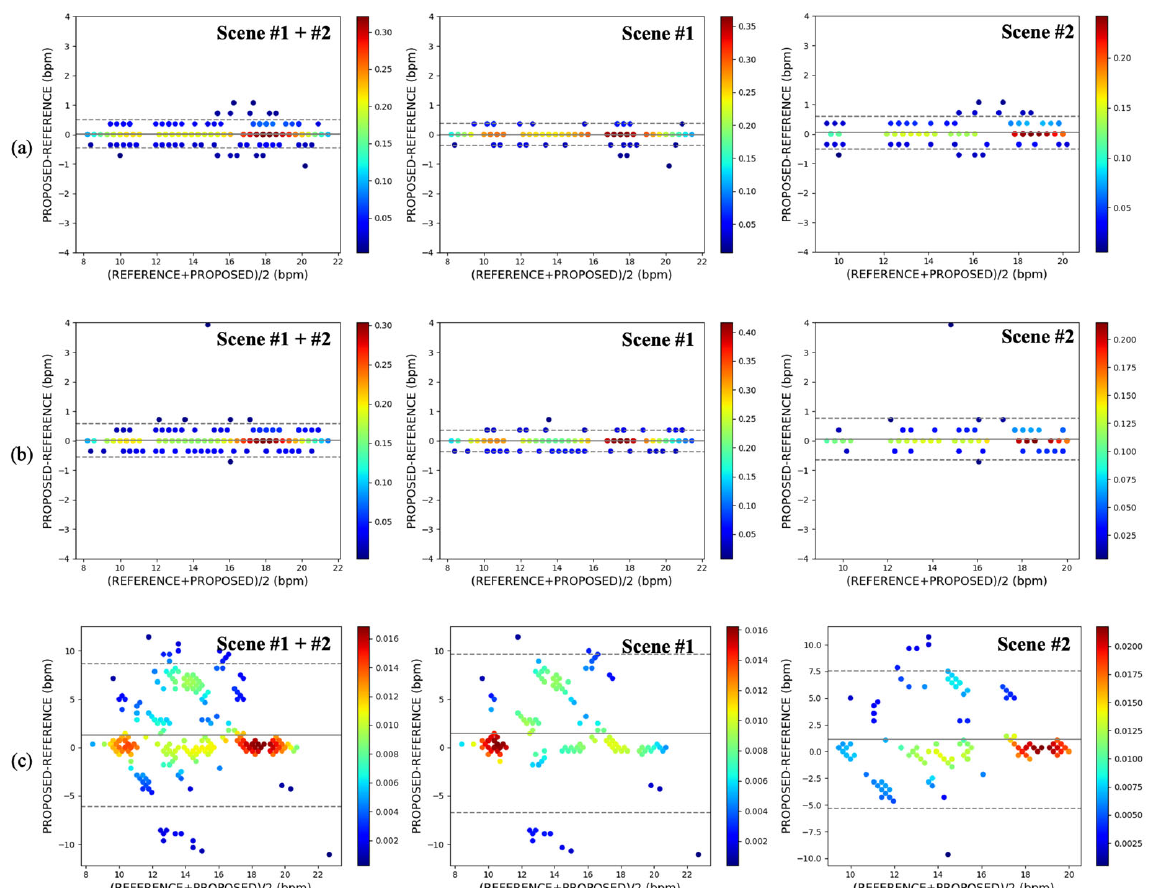
Figure 11. Bland–Altman plot of three breathing estimation methods for scene #1 and #2: ( a ) ours, ( b ) optical flow-based, and ( c ) intensity-based.